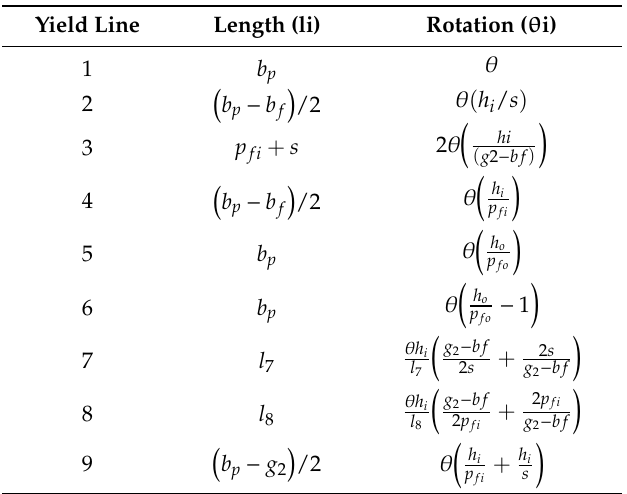
Table 1. Virtual rotations ( θ ) and yield line lengths ( l